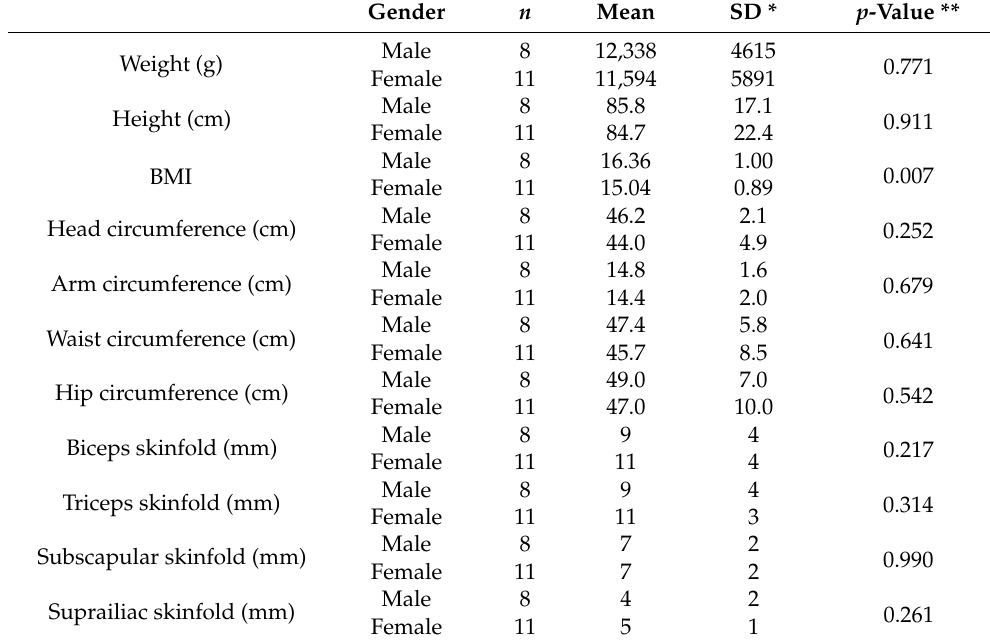
Table 1. Anthropometric characteristics of the infant population of the Chirikyacu community. Gender n Mean SD * p -Value ** Weight (g)